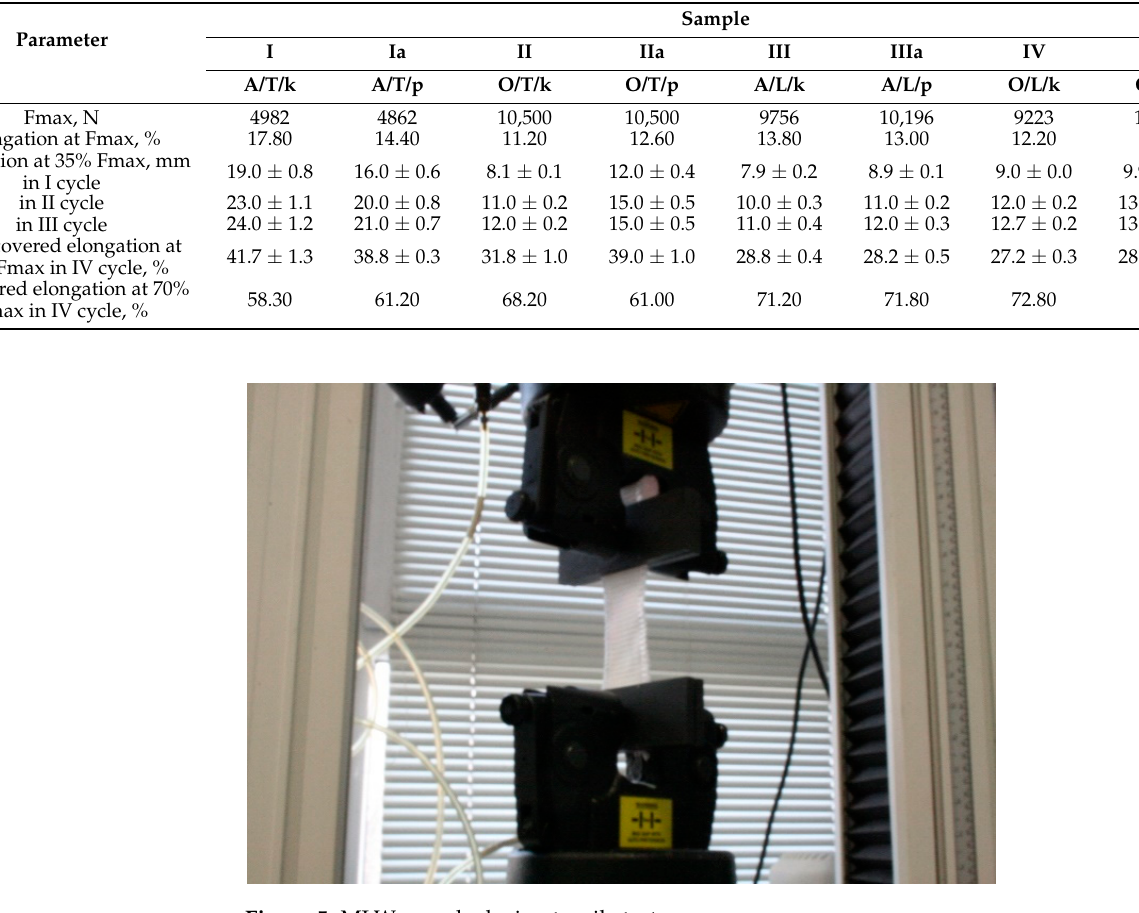
Figure 5. MLW sample during tensile test. Table 4. Summary of test results of mechanical properties of the woven.